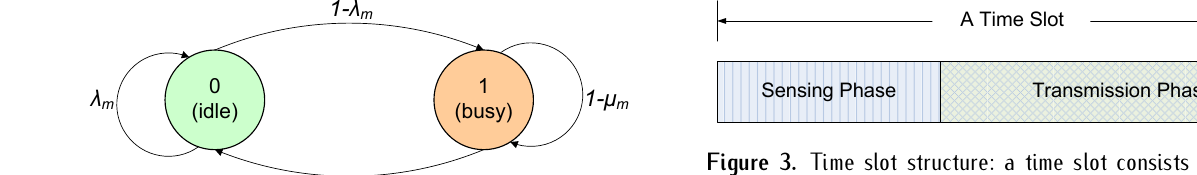
Figure 3. Time slot structure: a time slot consists of a sensing phase and a transmission